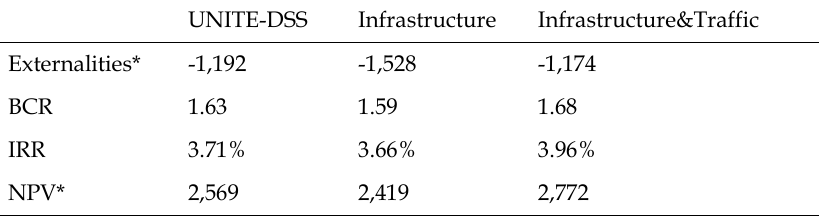
Table 4. UNITE-DSS-LCA results UNITE-DSS